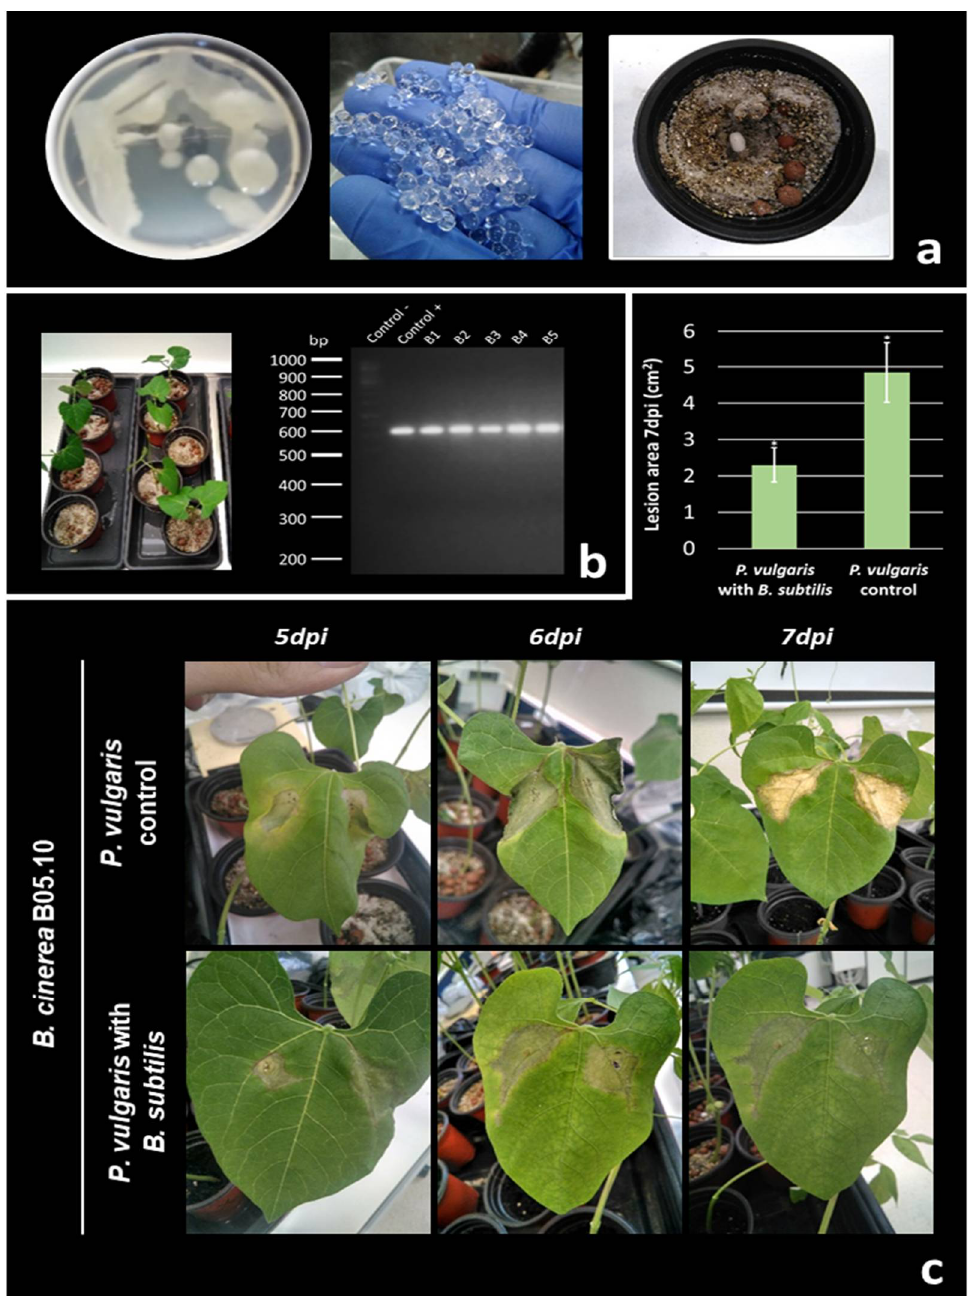
Figure 8. ( a ) Bacteria encapsulation in alginate beads; bean seeds inoculated with B. subtilis encap- sulated in alginate beads. ( b ) Bean plants growing in the greenhouse; products amplified by PCR with primers Bsub5F-Bsub3R (600 bp) on the template of DNA samples extracted from bean plants inoculated with B. subtilis (B1-B5) and DNA of B. subtilis and P. aeruginosa as control positive and negative, respectively. DNA molecular market: GeneRul-er-100bp-Plus. ( c ) The graph shows the mean area of the lesions at 7 days post-inoculation (dpi) (* p < 0.05). Images show the course of infection in plant control in comparison with a plant germinated previously with B. subtilis along 5-, 6-, and 7-dpi (representative images of the lesions are shown on different leaves).